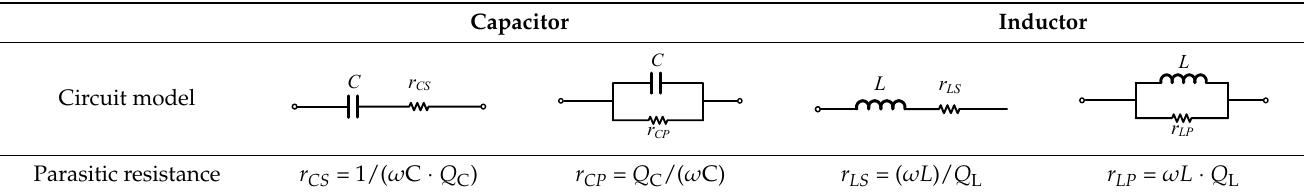
Table 4. Circuit Models Of Capacitor And Inductor With Parasitic Resistance.